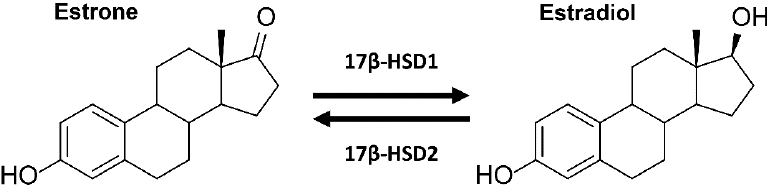
Figure 1. Interconversion of potent (estradiol) and weakly active estrogens (estrone) by 17 β -hydroxysteroid dehydrogenase (17 β -HSD)